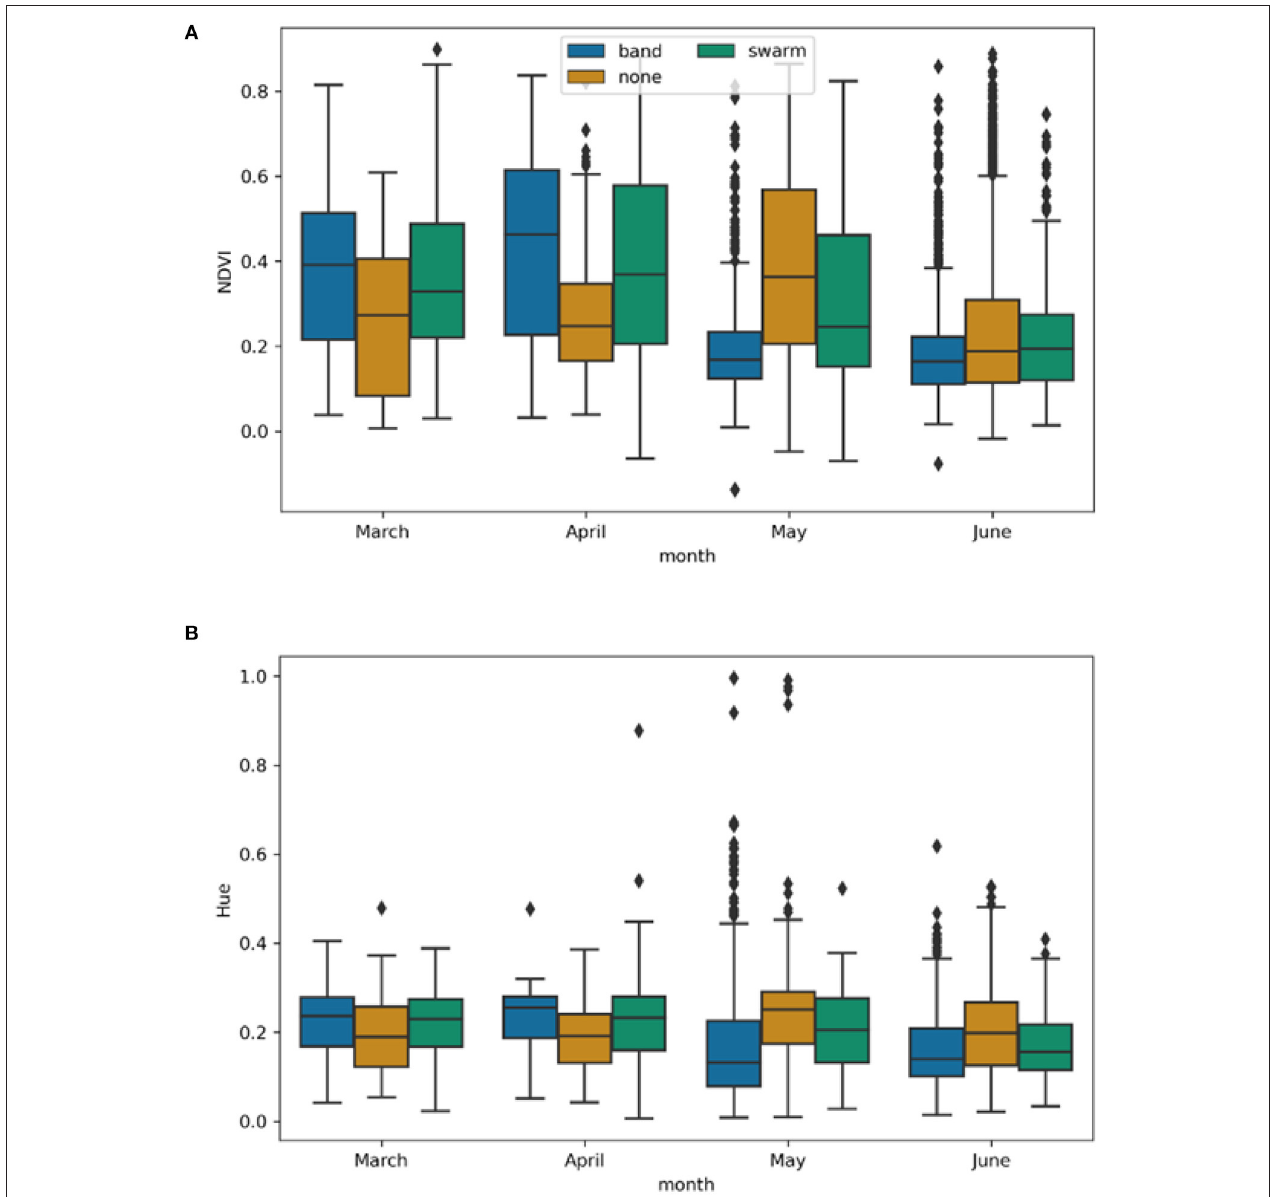
FIGURE 6 | (A) NDVI values at locust swarm, band, and non locust observations for the months of March through June 2020. (B) Hue values from the 7, 5, 4 band combination at the locust swarm, band, and no locust observations for the months of March through June 2020. Neither index showed distinct differences between locust activity and non locust